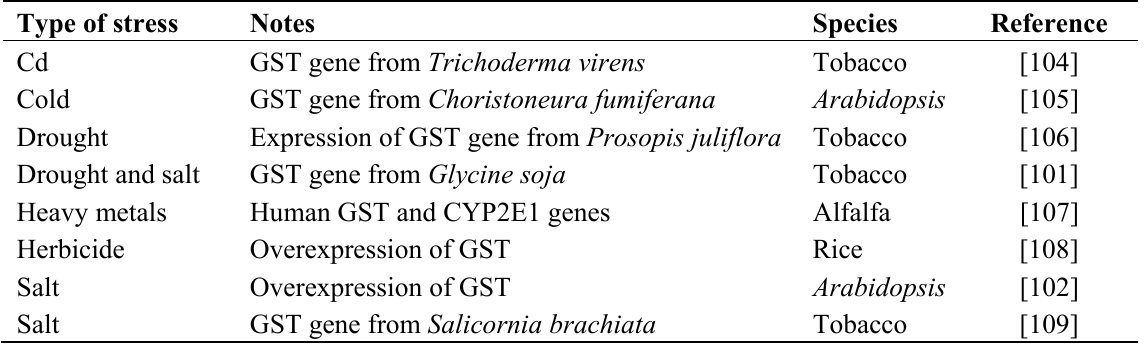
Table 1. Selected reports on glutathione-S-transferase (GST) overexpression and/or heterologous expression that enhanced abiotic stress tolerance in plants. All examples include mutational overexpression of endogenous GST or transgenesis of GSTs from wild species and basal eukaryotes with no economic significance into commercial species and model